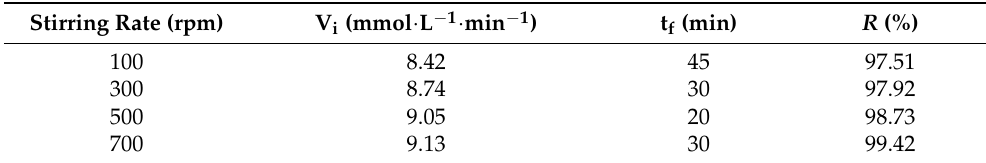
Figure 4. Variations of ( a ) pH and ( b ) phosphorus concentration over time for different stirring rates, an initial phosphorus concentration of 600 mg · L − 1 , and a solution volume of 600 mL. Table 2. End of precipitation time (t f ), initial precipitation rate (V i ), and phosphorus removal efficiency ( R %) for different stirring rates, an initial phosphorus concentration of 600 mg · L − 1 , and a solution volume of 600 mL.